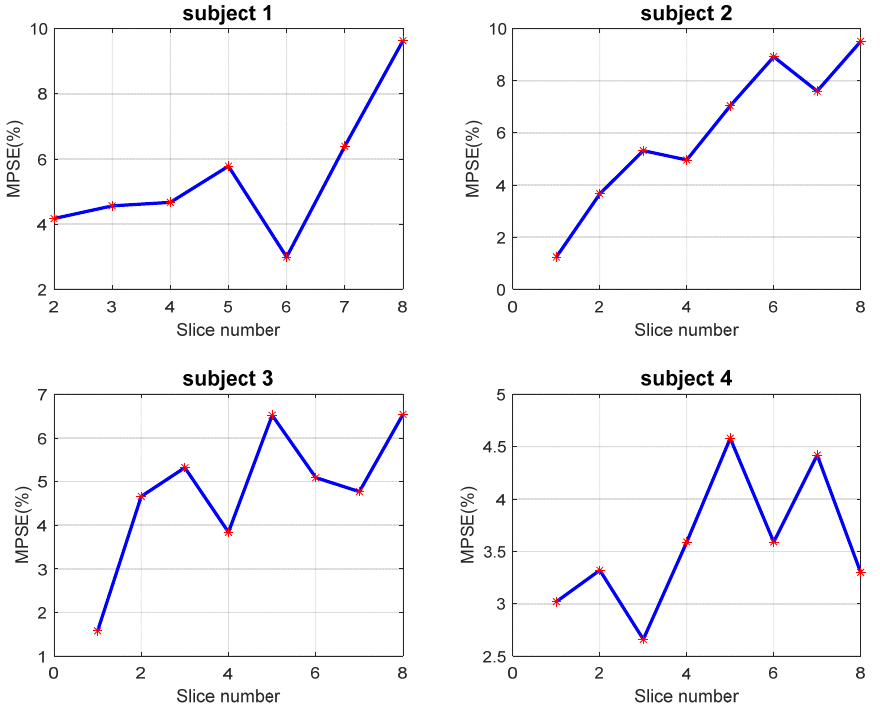
Figure 7. MPSE of four subjects on eight slices without respiratory motion segmentation. There are seven slices for subject 1 and 8 slices for all other subjects. Table 1. Subject demographic information, as well as median PSE of masked OE volumes.